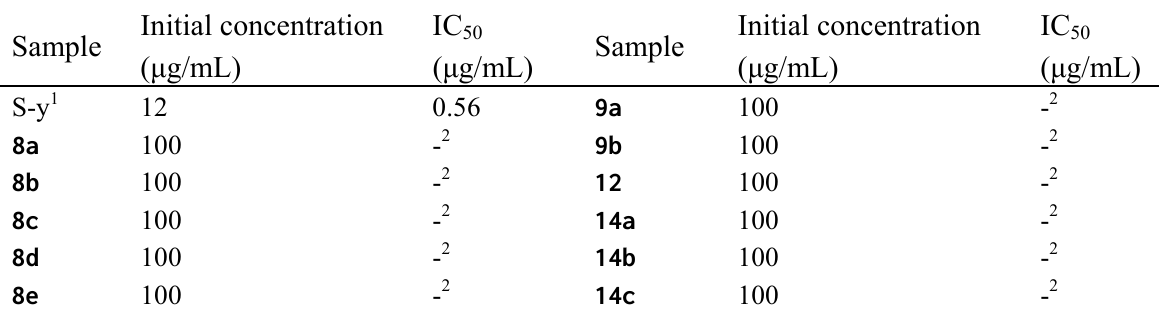
Table 1 . Integrase inhibitory activity data of 4-oxo-4 H -quinolizine-3-carboxylic acid derivatives.